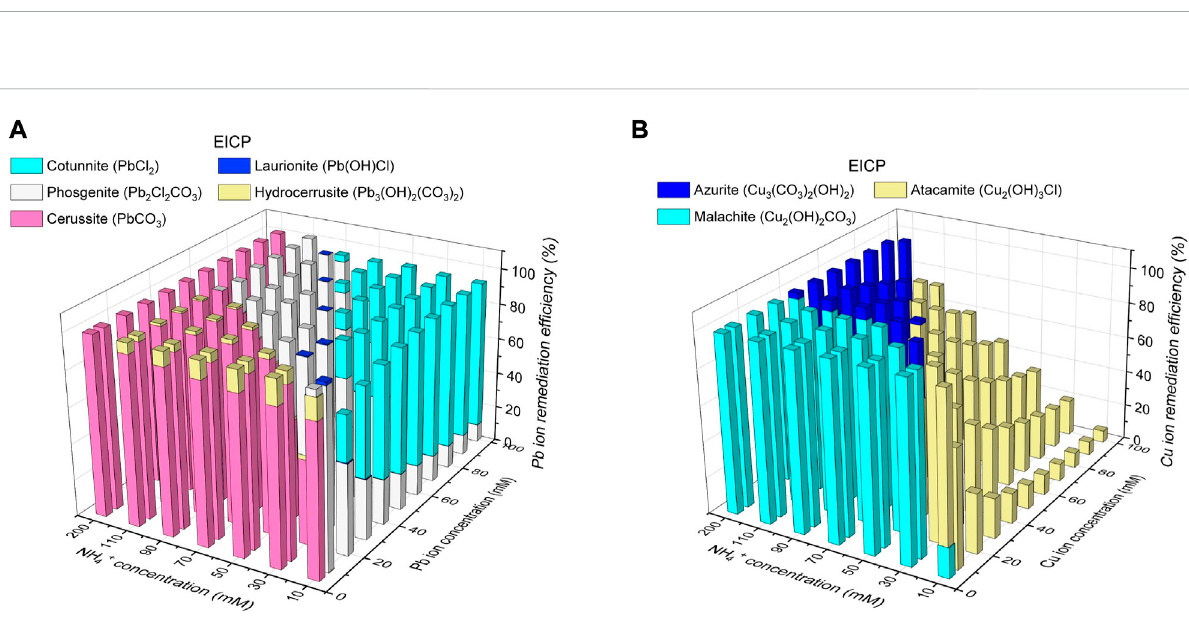
FIGURE 7 (A) Variations of remediation ef fi ciency against hydrolyzed urea concentration and Pb 2+ concentration under EICP and (B) variations of remediation ef fi ciency against hydrolyzed urea concentration and Cu 2+ concentration under